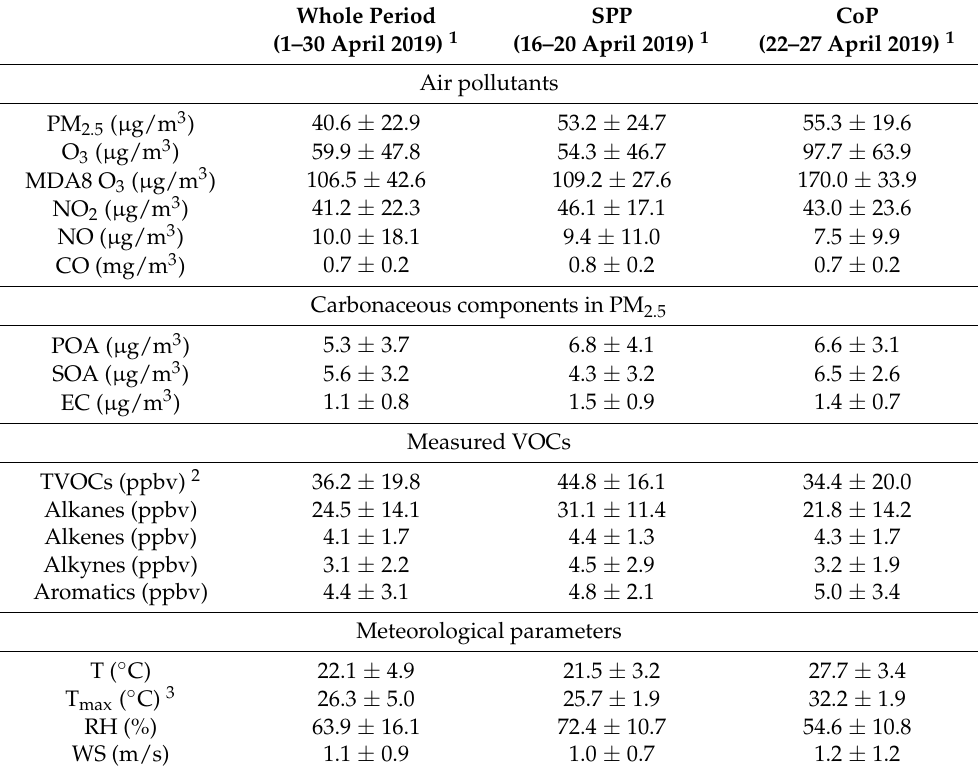
Table 1. Statistical summary (mean ± std) of measured air pollutants, carbonaceous components in PM 2.5 , VOC, and meteorological parameters in this